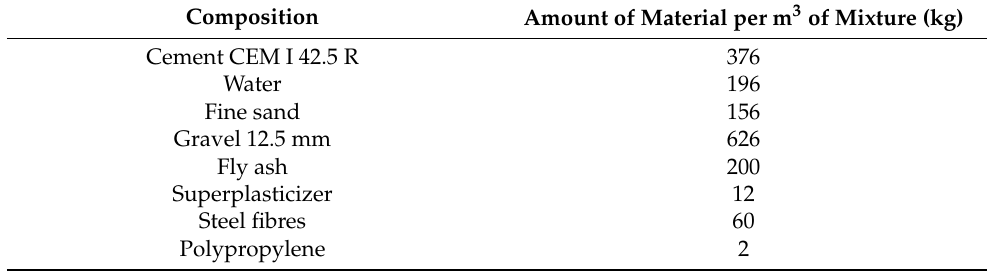
Table 1. Composition of the FRC mixture.